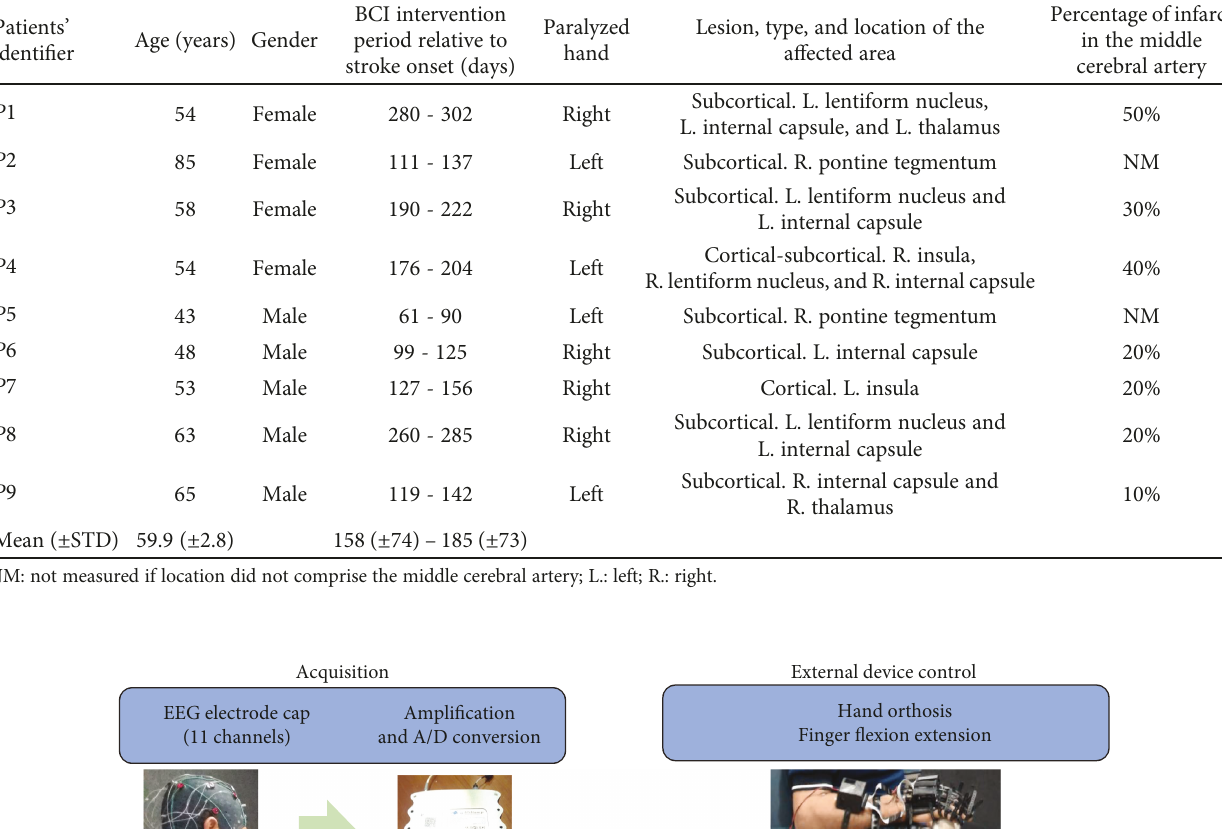
Table 1: Clinical and demographic information of stroke patients ’ data included in the present study. Each patient ’ s time since the beginning of the BCI of intervention, relative to stroke onset, and time at the end of the BCI intervention is shown. Percentage of infarct in regions related to the middle cerebral artery was assessed using the ASPECTS scale [23].